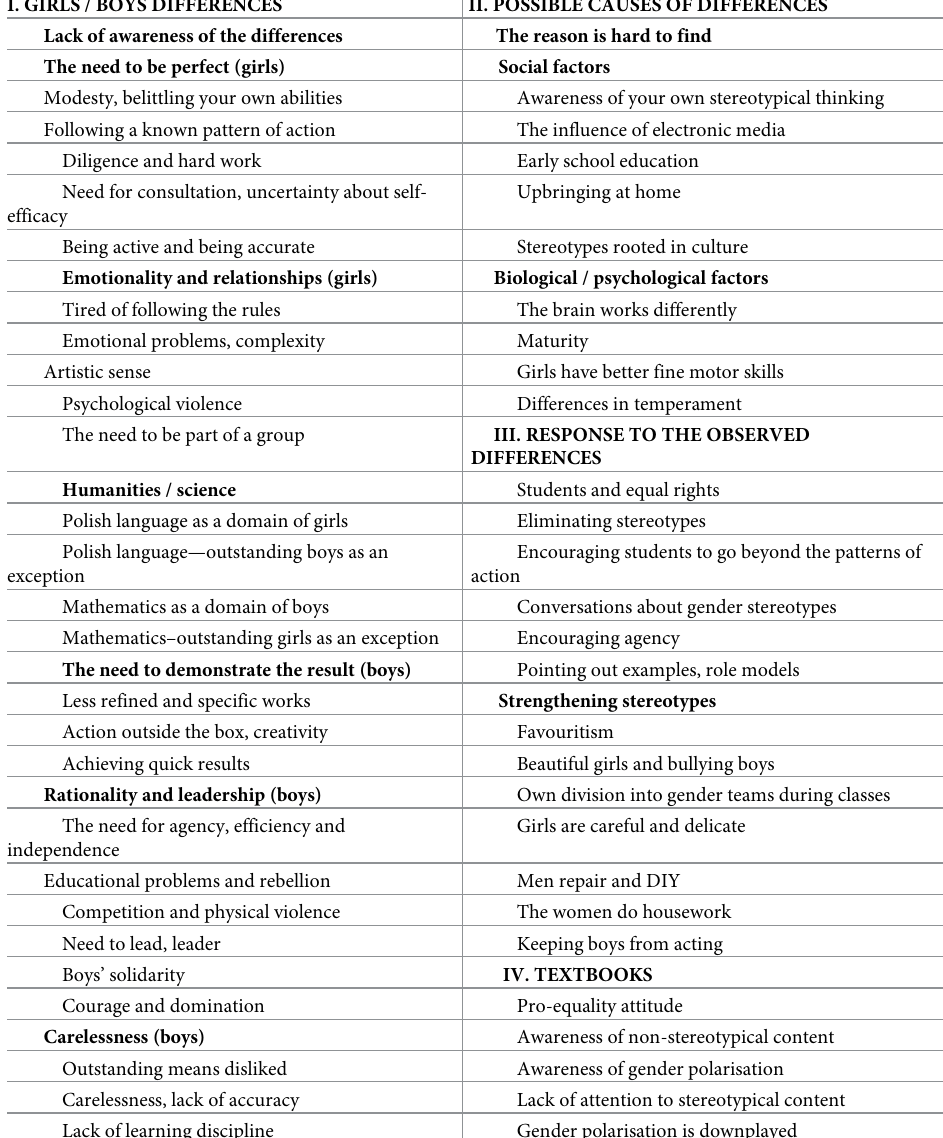
Table 3. The final number of themes, categories and codes. I. GIRLS / BOYS